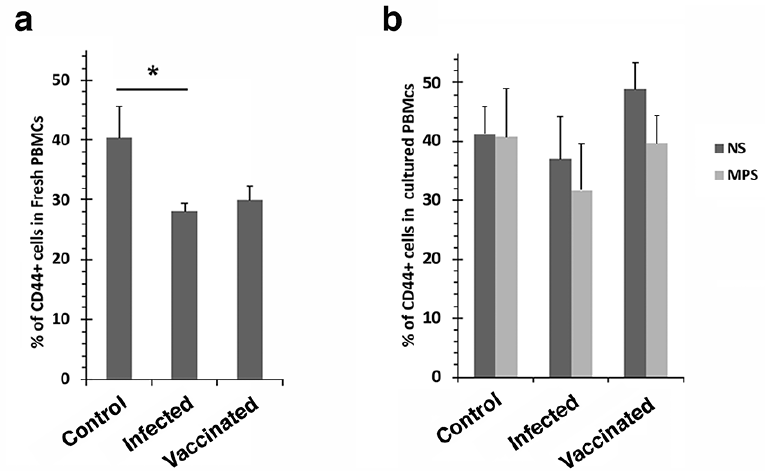
Figure 4. CD44+ T cell proliferation of fresh ( a ) and cultured PBMCs ( b ) in response to Map antigen. The percentage of fresh CD44+ decreased in the infected and vaccinated groups ( a ). No significant responses were observed in cultured PBMCs ( b ). Asterisk indicates a p value of less than 0.05. Treatments: NS = no stimulation and MPS = stimulation with Map antigen.